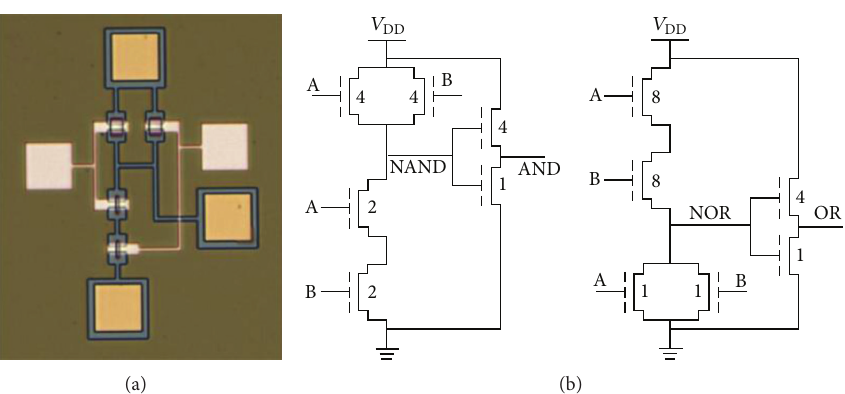
Figure 4: (a) Optical microscope image of a 2-input NAND gate fabricated using nc-Si TFTs. (b) Circuit diagram of the NAND, AND, NOR, and OR logic gates. The AND and OR gates are built by adding an inverter at the out of the NAND and NOR gates, respectively.